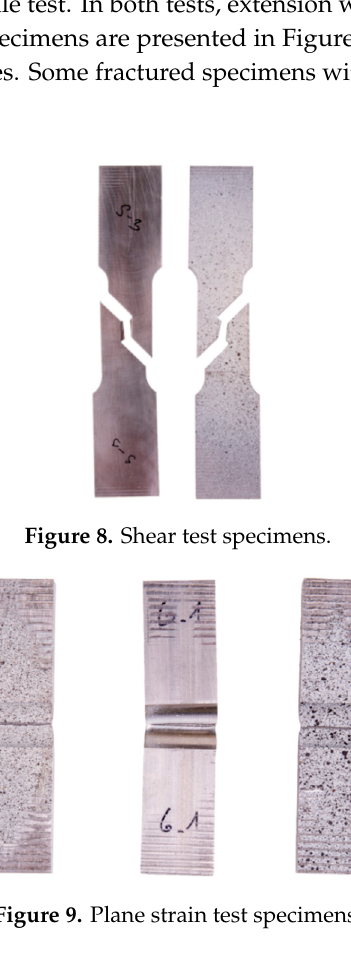
Figure 9. Plane strain test specimens.